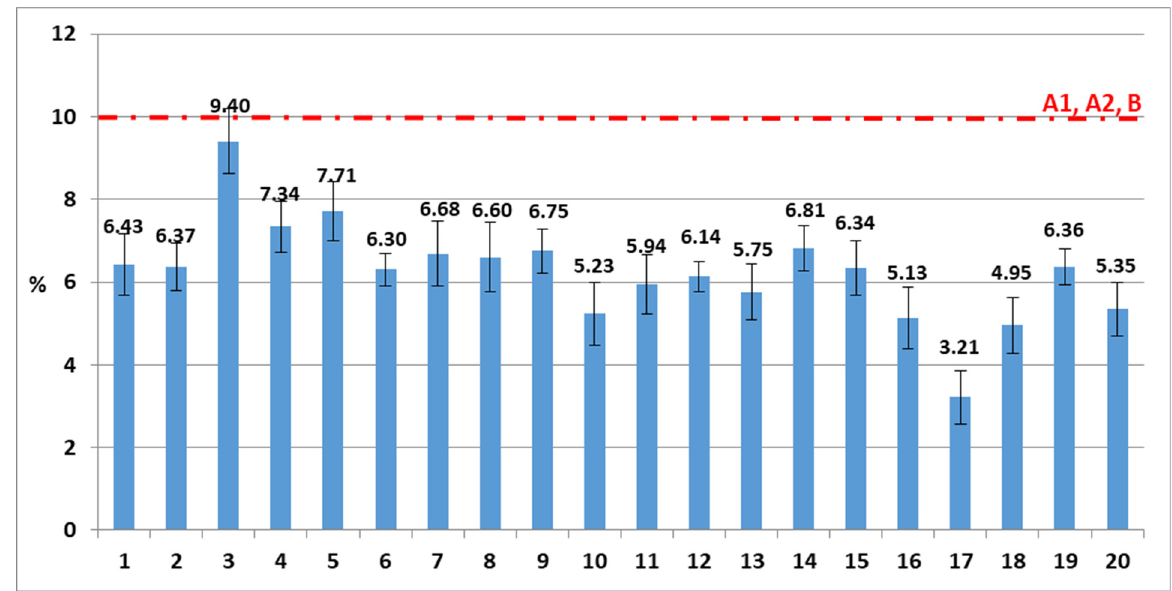
Figure 11. Mean moisture content values (%) of the 20 examined pellet brands (the red dashed line depicts the quality classes’ threshold value).